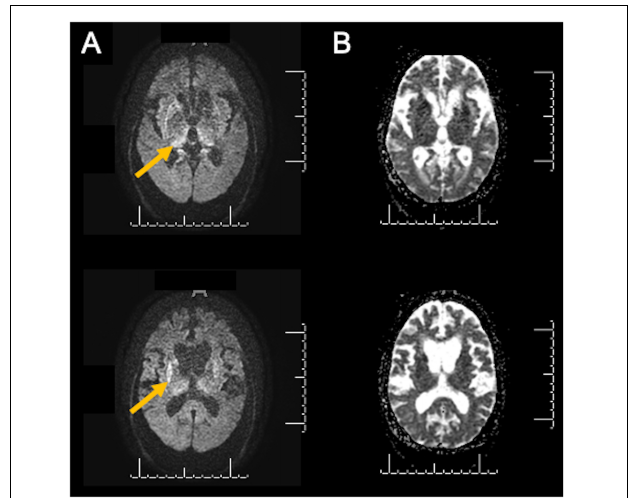
FIGURE 3 | Diffusion-weighted images (DWI) from ABT (case 1) revealing enlarged ventricles and symmetric hyperintensities in the basal ganglia ( A , yellow arrows). (B) shows corresponding apparent diffusion coefficient (ADC) hypointensities in the same territory.